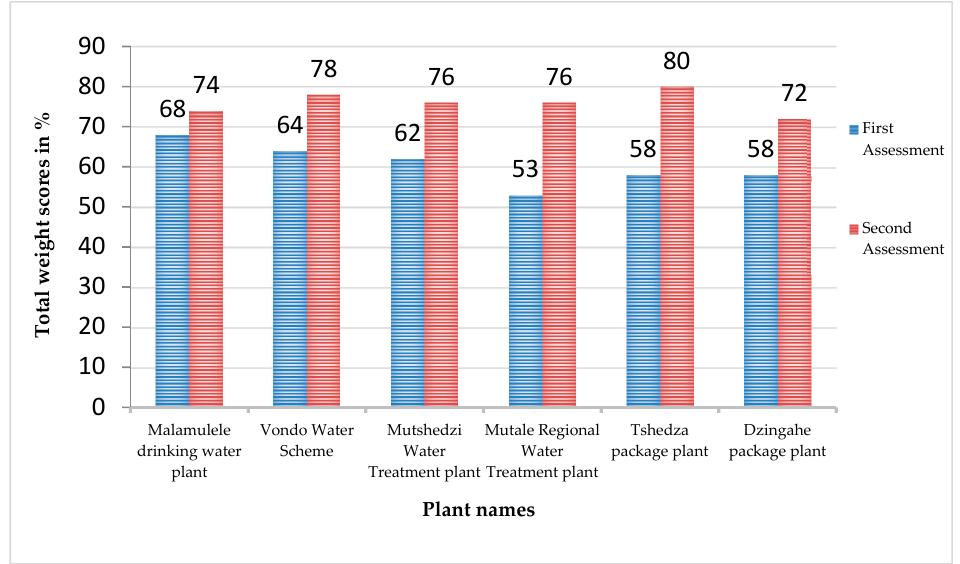
Figure 5. Overall scores for non-technical compliance assessment between August 2008 and June 2009 and the second assessment between November and December 2010.